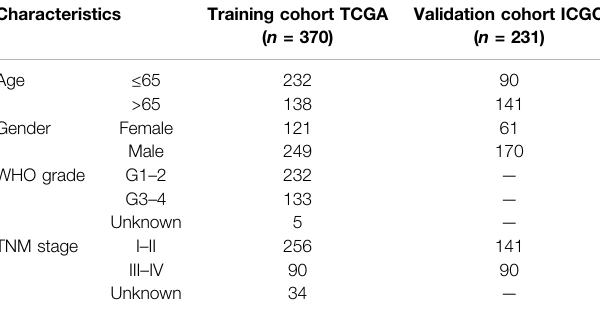
TABLE 1 | Characteristics of hepatocellular carcinoma (HCC) patients in the training and validation cohorts.